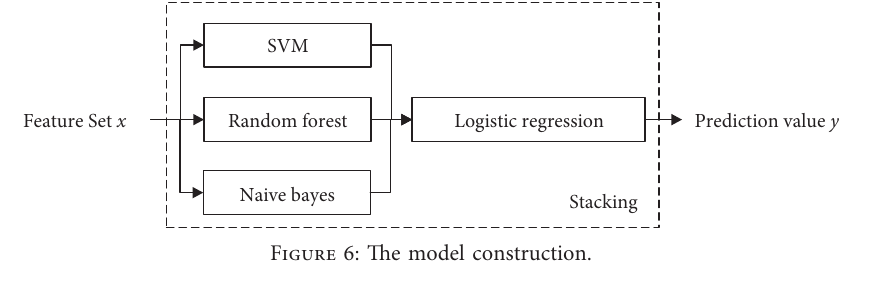
Figure 6: The model construction.